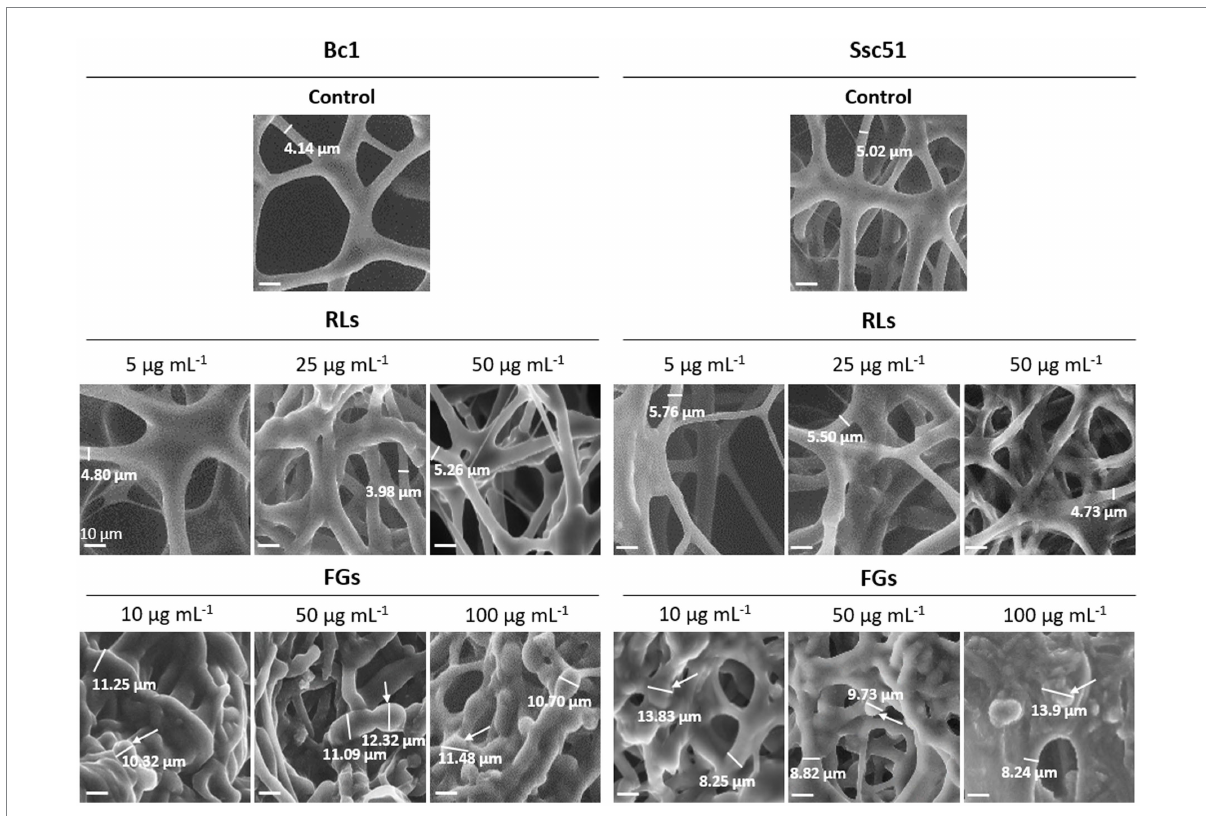
FIGURE 2 Structural alterations induced by RLs or FGs on B. cinerea Bc1 and S. sclerotiorum Ssc51 strains. Scanning electron microscopy observations of mycelium after treatments with different concentrations of RLs or FGs. The thickness of the mycelium is indicated by a measurement under a dash on each picture and vesicle-like structures are indicated by arrows. Scale bar: 10 μ